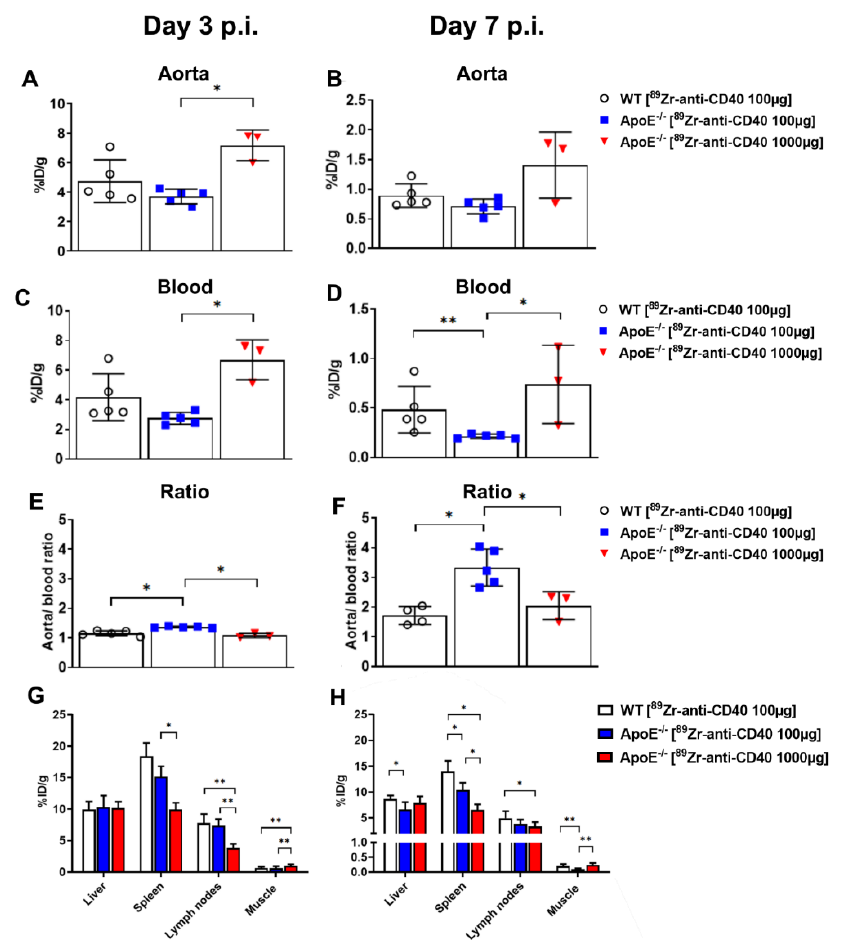
( middle ), and CT image overlayed with PET ( right ). White arrows indicate apparent uptake in plaques. Data is expressed in percent injected dose per gram tissue (%ID/g).